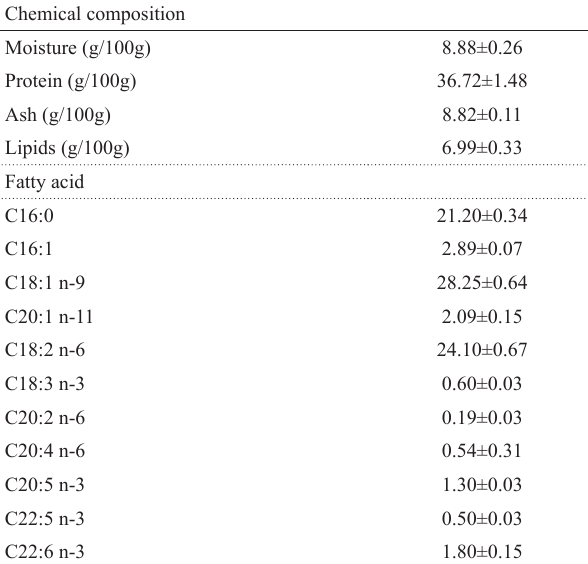
Tab. 2. Fatty acid composition (g\100g fatty acid) of Lophiosilurus alexandri from lotic and lentic environments and aquaculture. Mean ± standard deviation (n=5) followed